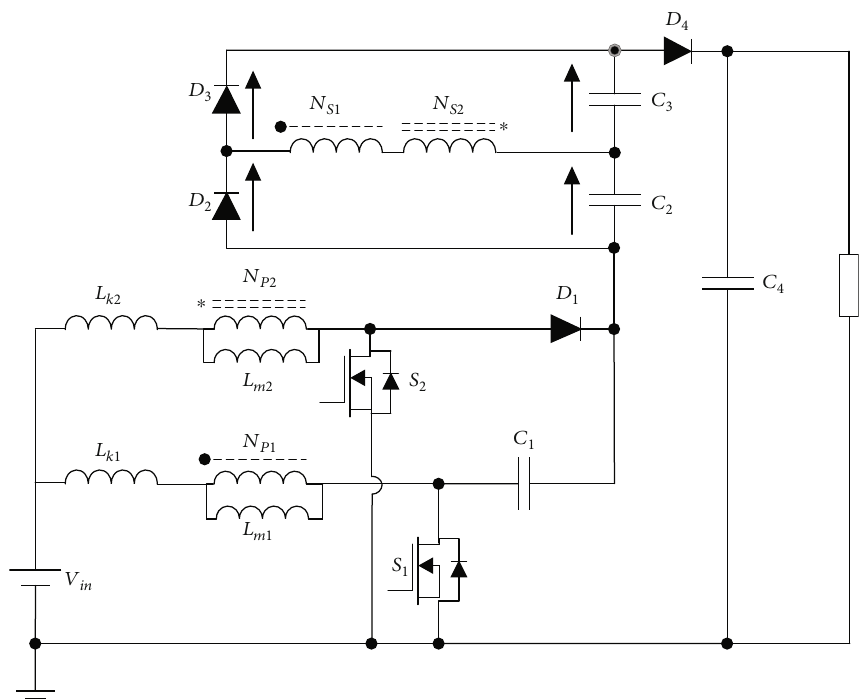
Figure 2: Equivalent topology of the proposed